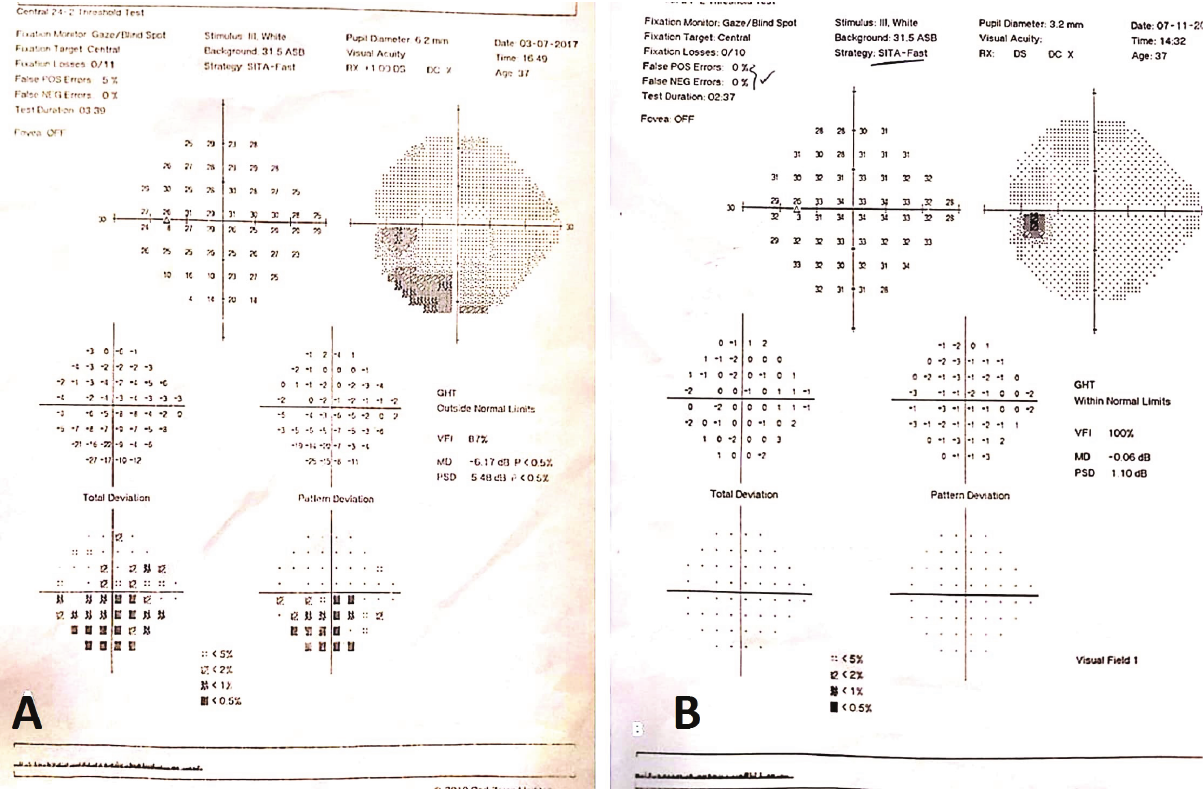
Figure 2. Automated visual field test (24-2 threshold) of the left eye; at presentation (A) reveals inferior visual field defect, and three months later (B) shows complete recovery without